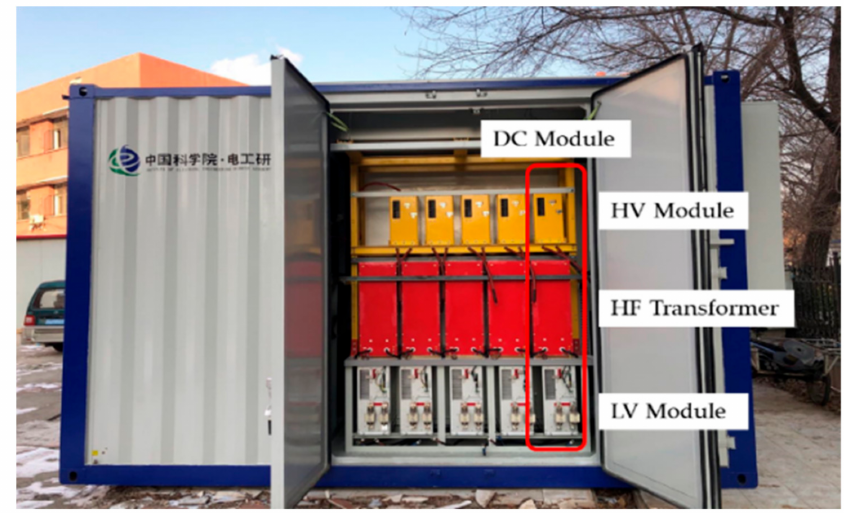
Figure 15. 20 kV/500 kW series-connected PV MVDC converter.